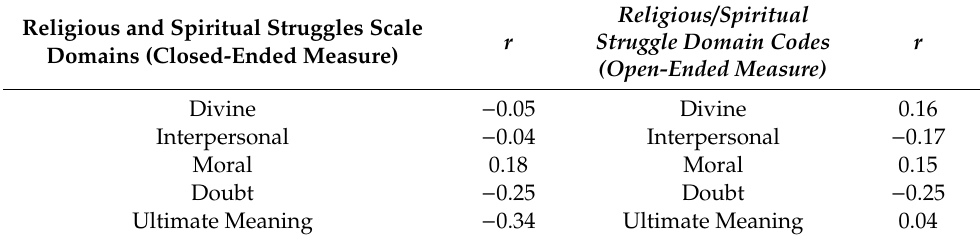
Table 5. Spearman Correlations Relating Closed-Ended and Open-Ended Measures of Religious and Spiritual Struggles to Religious Belief